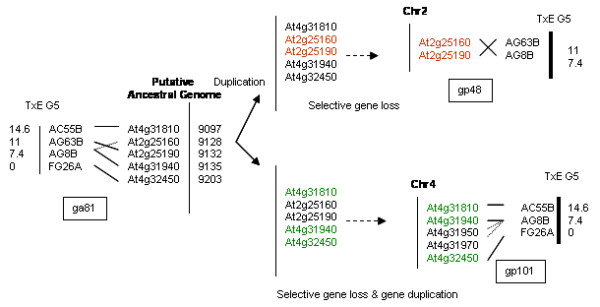
Proposed evolutionary steps involving some syntenic blocks between Arabidopsis and the Prunus genomes. Blocks in the putative ancestral Arabidopsis genome and Arabidopsis chromosome 2 and 4 that match to the same block in Prunus TxE map are illustrated. Red and green colors were used to help track the genes. Dashed lines were used to indicate the relationship with less stronger homology when the same EST was homologous to more than one Arabidopsis genes.